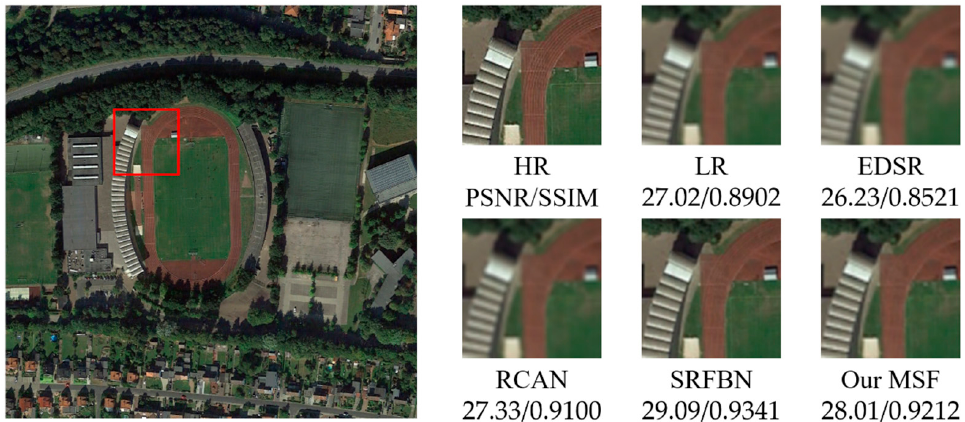
Figure 8. Qualitative comparison between different SR models performance on stadium instance-class.